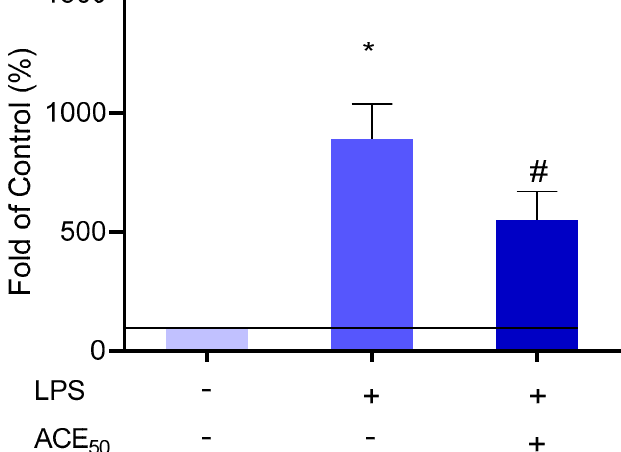
Figure 9. The level of PGI 2 increased significantly compared to the control after LPS-treatment indicated by *. # indicates the significant changes in PGI 2 in LPS-induced inflammation and ACE 50 treatment compared to the level of PGI 2 in LPS-induced inflammation without ACE 50 . Results are expressed in the percentage of the control (100% is represented by the solid lines). Data are expressed as the mean ± SEM of four individual experiments. ACE 50 , 50 µ g / mL anthocyanin extract.